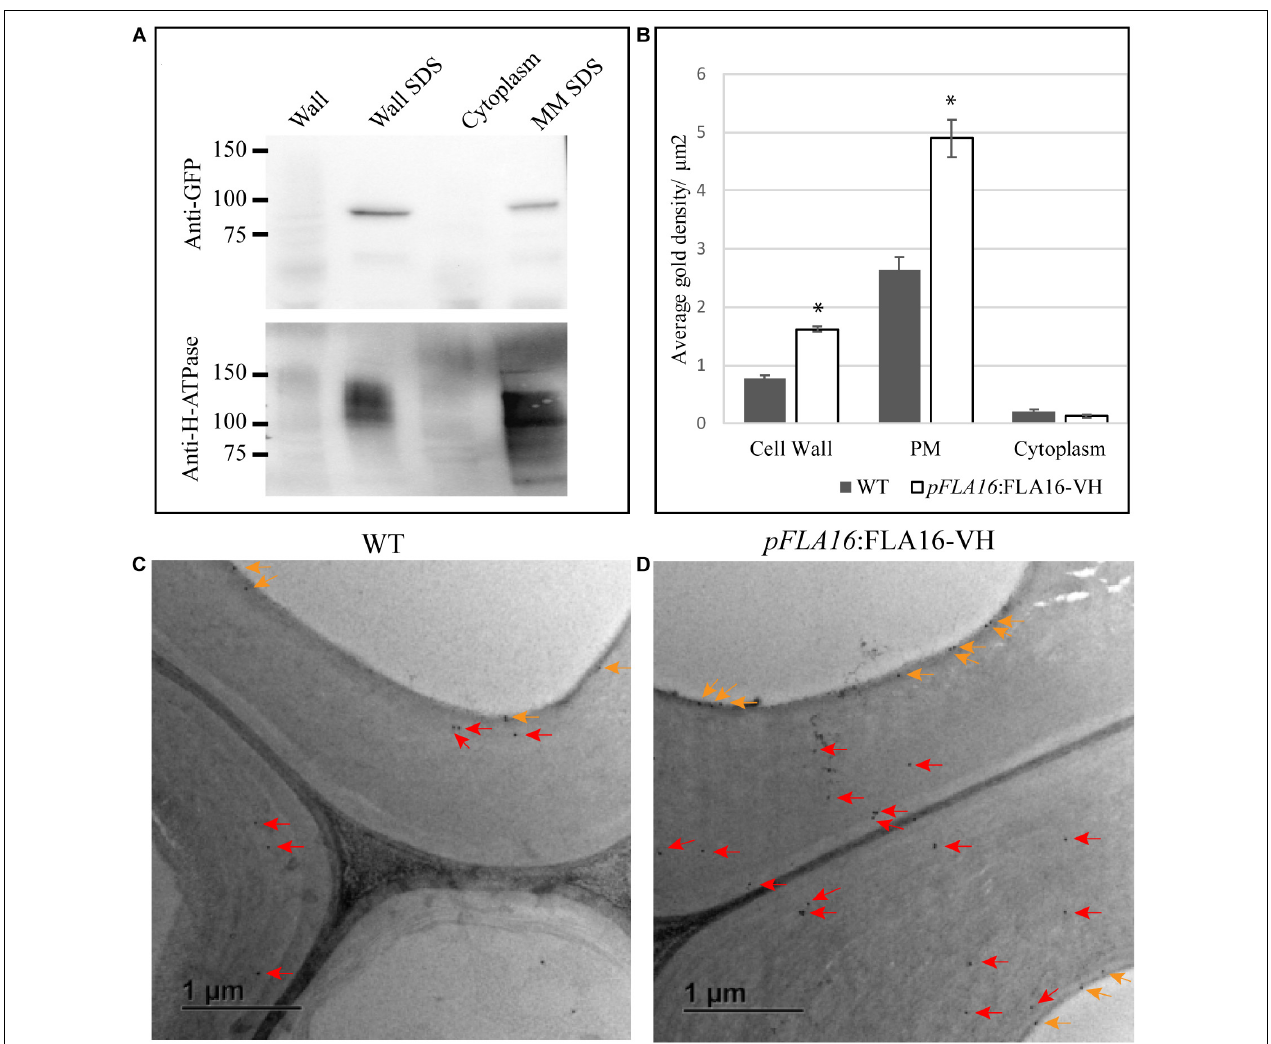
FIGURE 3 | Detection of FLA16-VH fusion proteins in Arabidopsis stems. (A) Proteins extracted from stems were fractionated into wall, SDS wall extract (Wall SDS), microsomal membranes extracted with SDS (MM SDS) and cytoplasm. FLA16-HV is detected in both Wall SDS and MM SDS fractions using an anti-GFP antibody (upper panel) . The Wall SDS and MM SDS fractions are enriched for Plasma Membrane (PM) as shown by replicate western blots probed with the anti-H-ATPase antibody bound in both. (B) Average gold density per 1 µ m 2 of interfascicular fiber cell wall, plasma membrane (PM) or cytoplasmic region for anti-HIS antibody in ultrathin sections of the stem at the first internode. Significantly higher amounts of gold labeling ( p < 0.05 using Student’s t test, indicated by *) are observed in the wall and PM of pFLA16:FLA16-HV plants compared to WT with no difference in the cytoplasm. n = 5–8 cells from two biological replicates. Error bars indicate standard error, p < 0.05 using t -test. (C,D) Transmission electron micrograph images of interfascicular fiber cells at the stem first internode of WT (C) and pFLA16 :FLA16-VH (D) . Gold labeling in the cell wall (red arrow) and plasma membrane (orange arrows) are